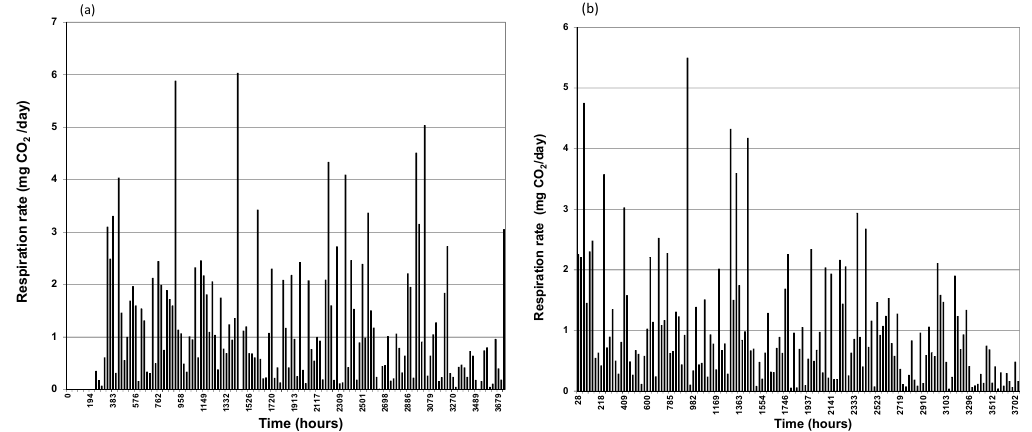
Figure 2. Instantaneous daily rates of CO 2 generation for biopile ( a ) Bio_Cont, ( b ) Bio_Stim.